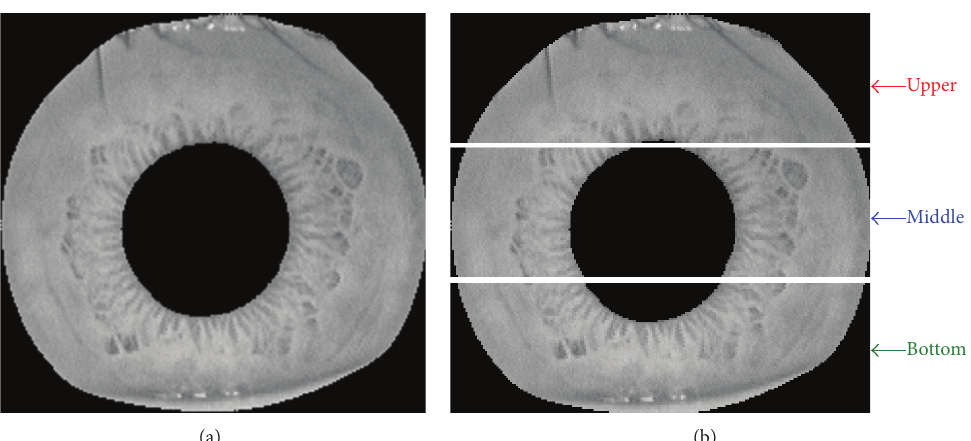
Figure 10: The partition process of segmented iris region. (a) Original segmented iris region. (b) Upper, middle, and bottom